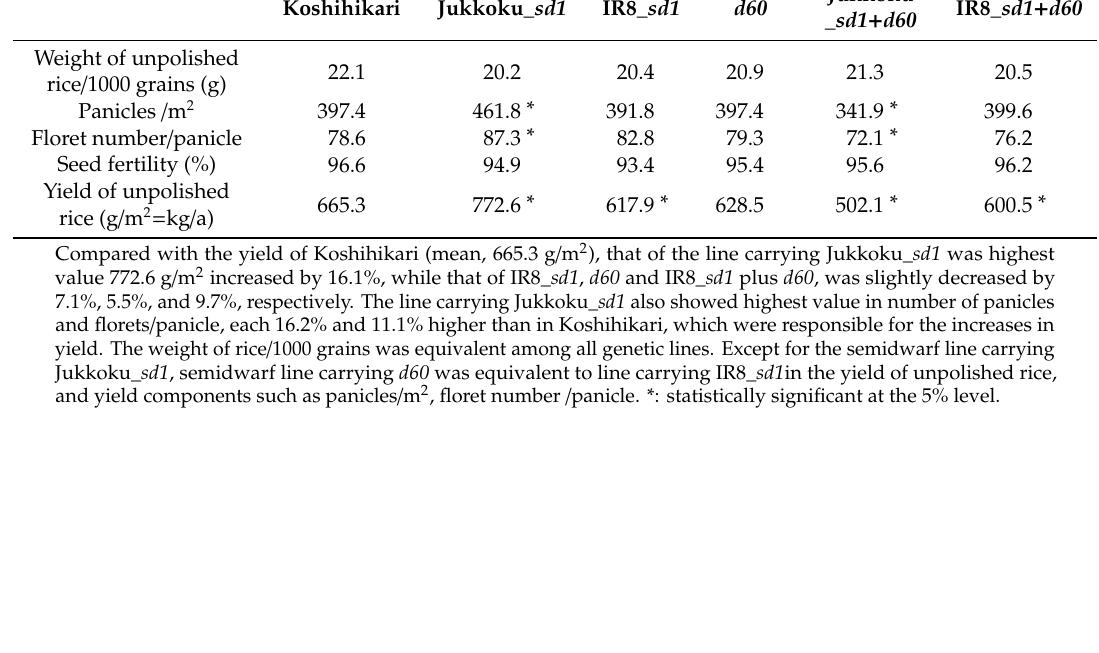
Table 2. E ff ect of semidwarf and double dwarf genes to yield components. Koshihikari Jukkoku_ sd1 IR8_ sd1